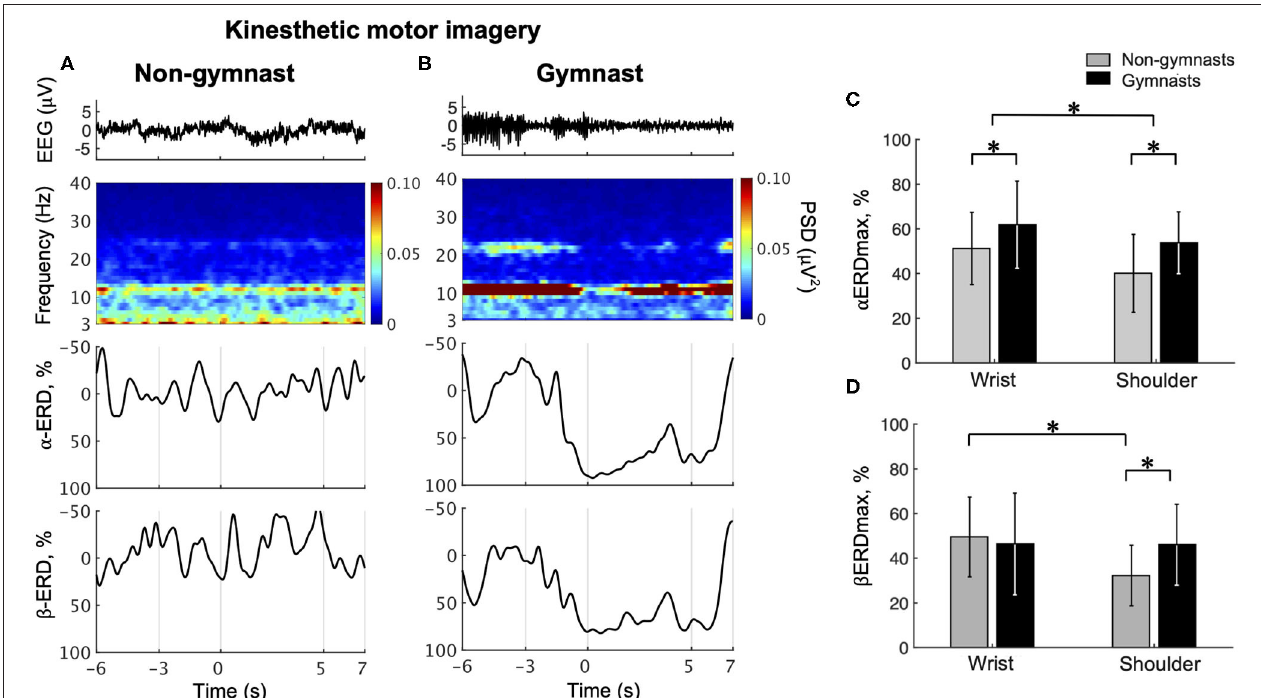
FIGURE 4 | Results from physiological experiments for KMI. Typical time courses of single-trial EEG, time-frequency map, α -band ERD, and β -band in wrist dorsiflexion KMI are shown for non-gymnast (A) and gymnast (B) participants. Note that participants performed wrist dorsiflexion KMI from 0 to 5s. Group data (mean ± S.D.) for α ERDmax (C) and β ERDmax (D) during KMI are shown across groups and tasks. The gray bars represent the data for non-gymnasts, while the black bars represent the data for gymnasts. * P <